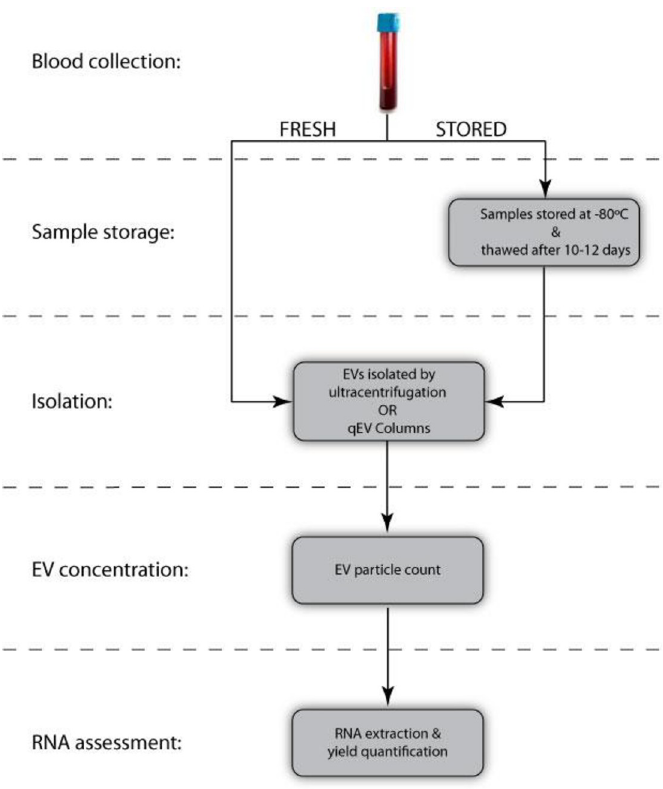
Fig 1. Sample handling protocol for EV isolation, particle analysis, and RNA characterization. Fresh versus stored samples containing plasma- or media-derived EVs were assessed for particle count (i.e. yield) and/or RNA yield/ quality after EV isolation using ultracentrifugation or qEV